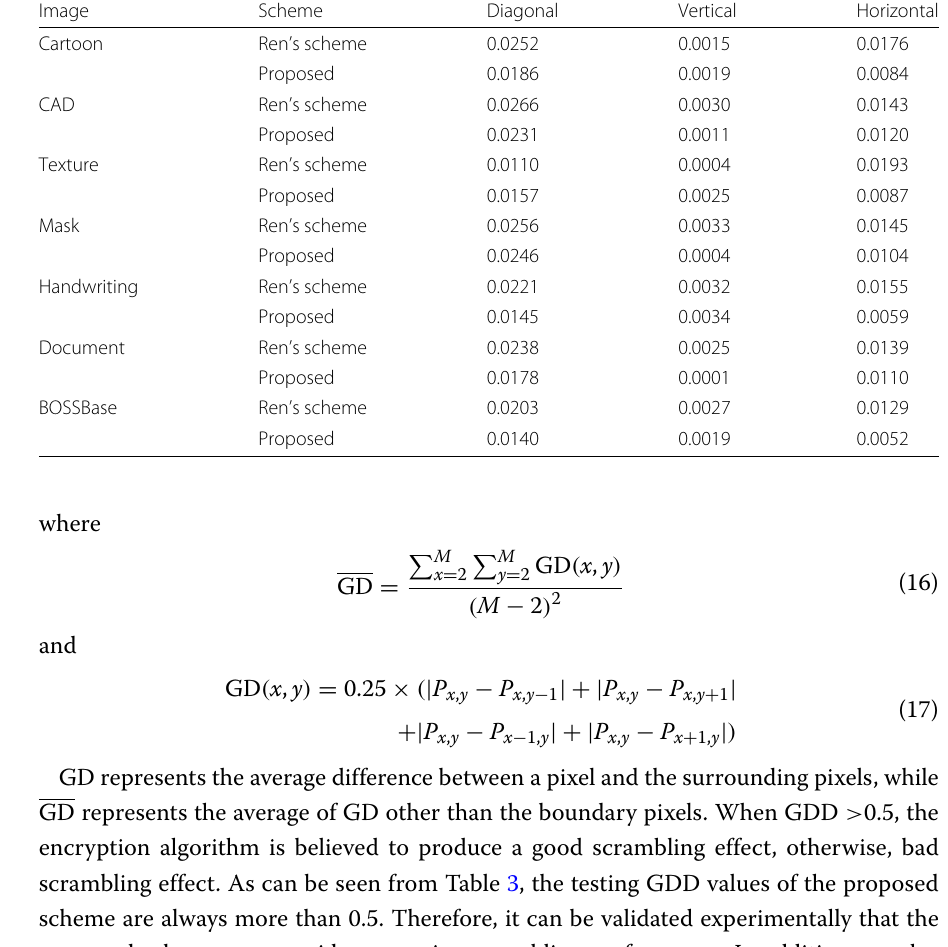
Table 2 The correlation analysis for the proposed scheme and Ren’s scheme [24]. The experimental images use both the classical binary images and BOSSBase database